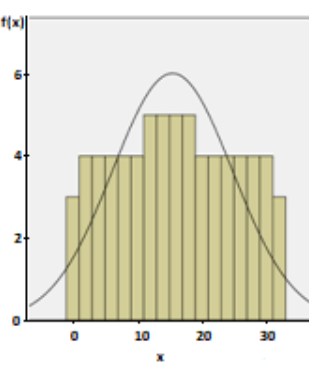
Fig 1b . Probability distribution differing significantly from normal [19].